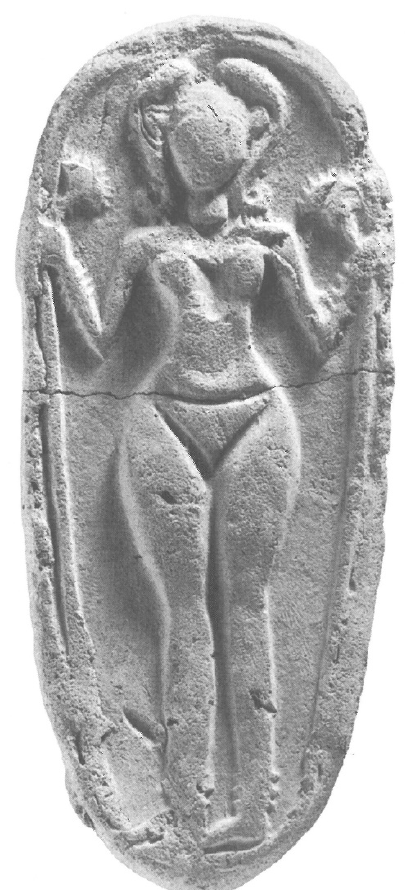
Figure 7. Canaanite Figurine plaque of a naked goddess from Tel Batash (From Mazar 2006: Photo 104; courtesy of Amihai Mazar and the Institute of Archaeology, The Hebrew University of Jerusalem).